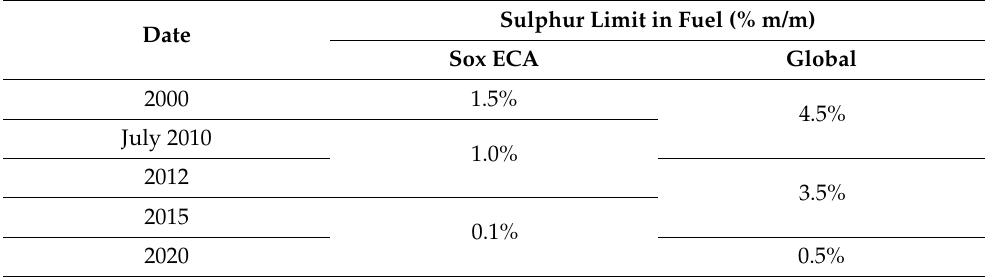
Table 2. Sulphur limits for marine engine fuel oil.